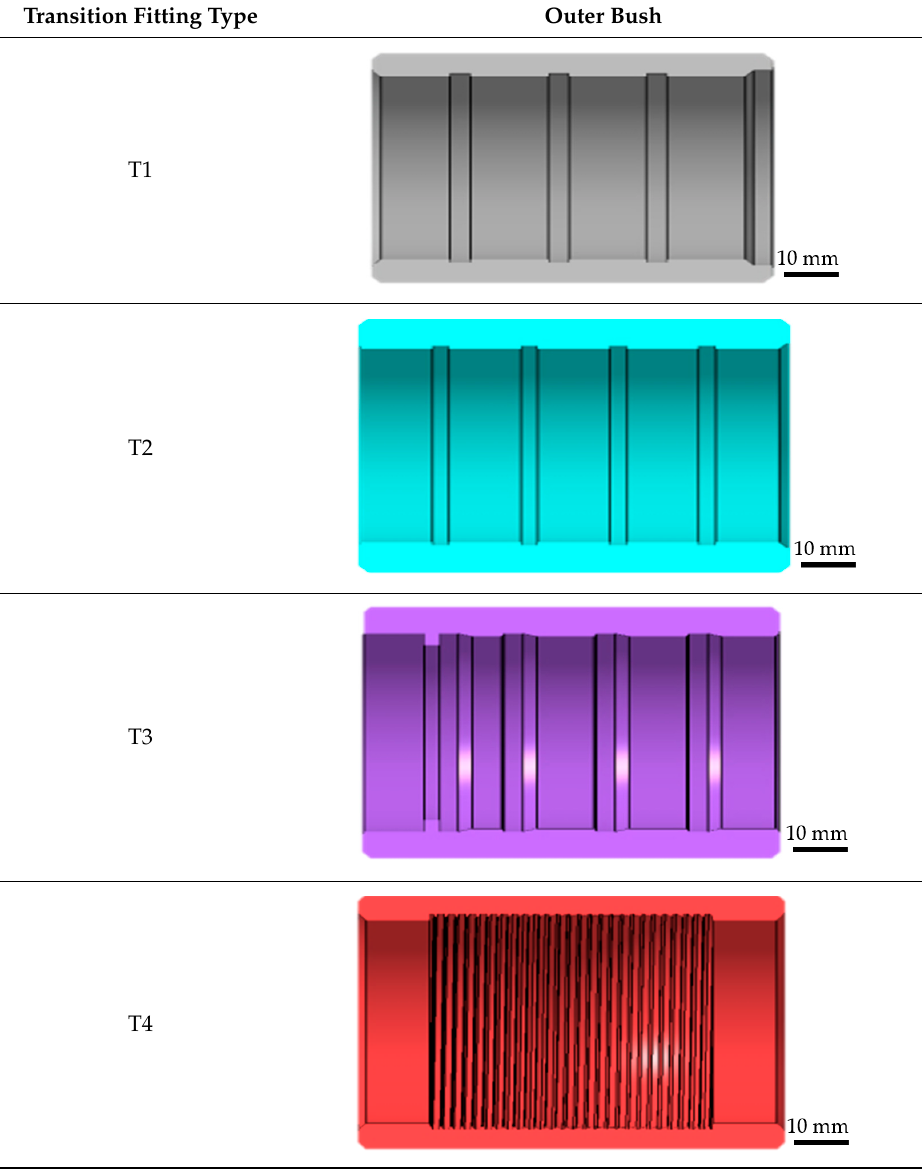
Table 10. Constructive shape of the outer bushes.